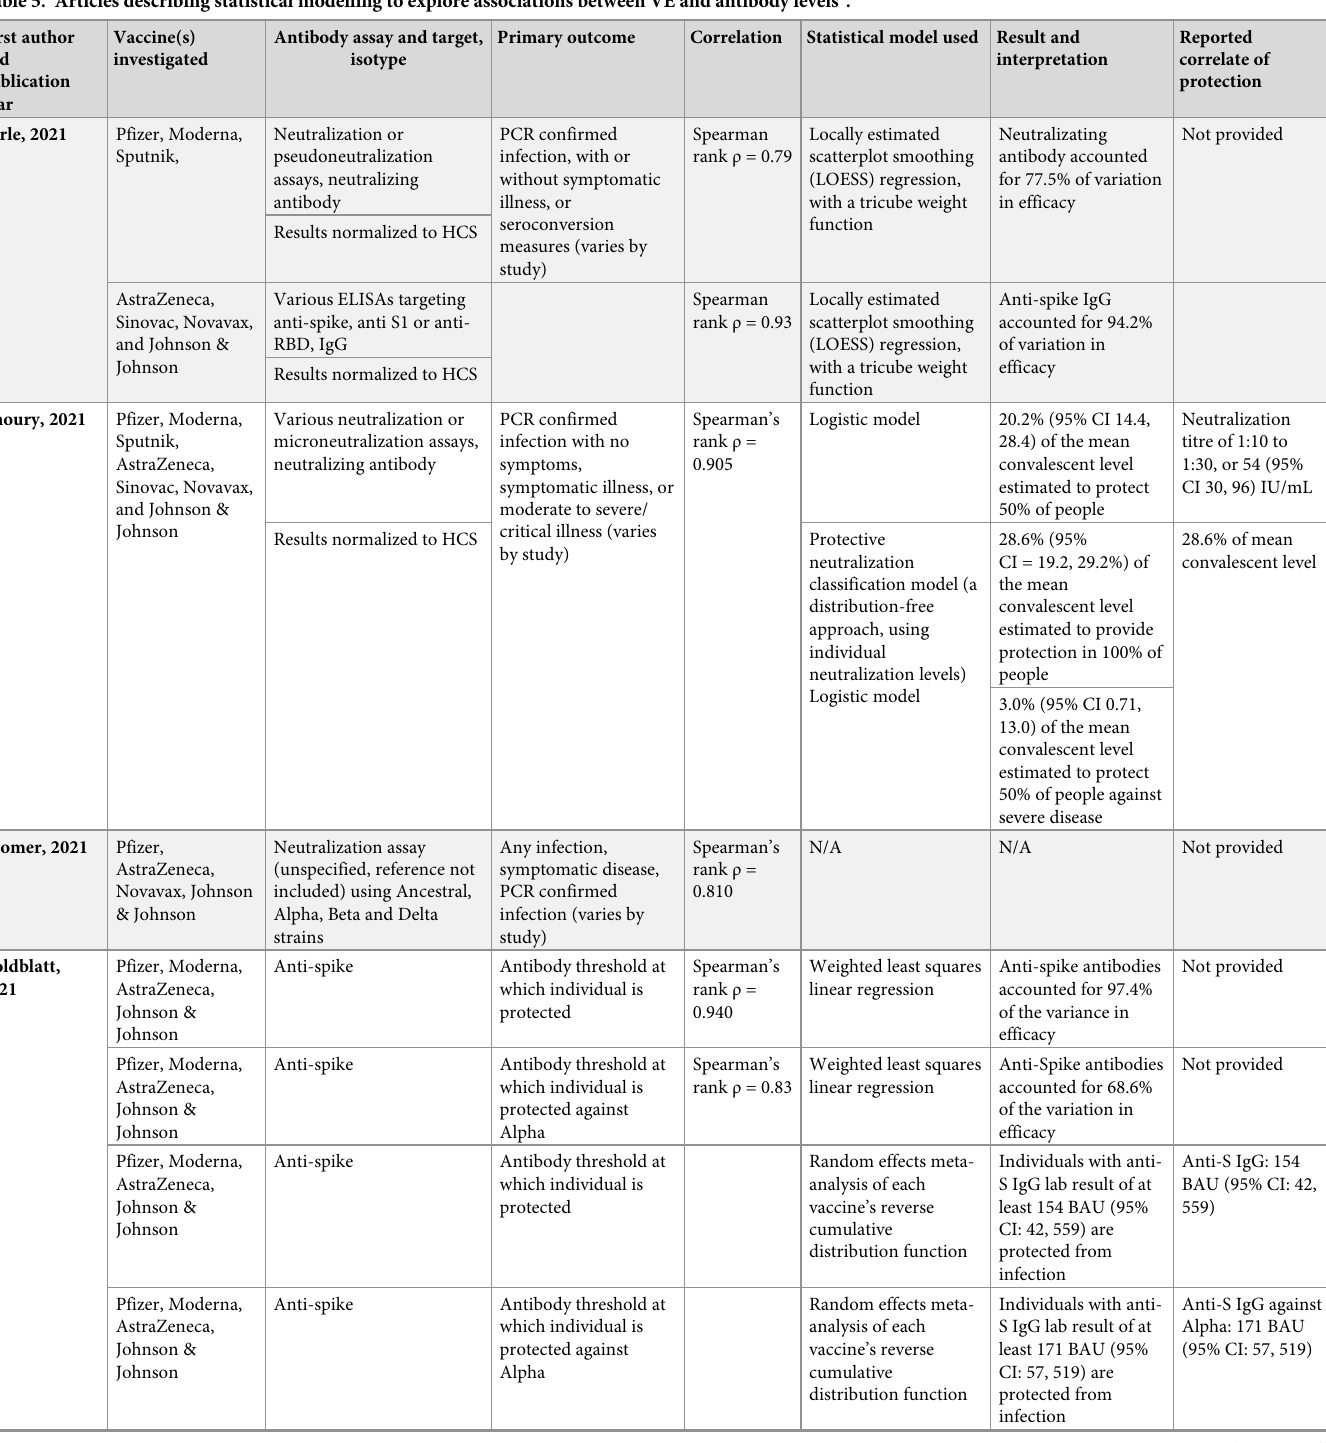
Table 5. Articles describing statistical modelling to explore associations between VE and antibody levels #